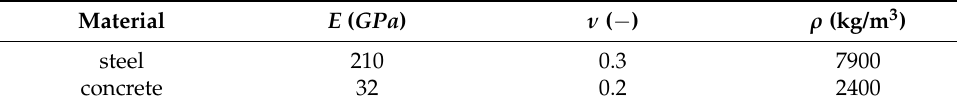
Table 2. Material parameters of steel and concrete used in the tests.